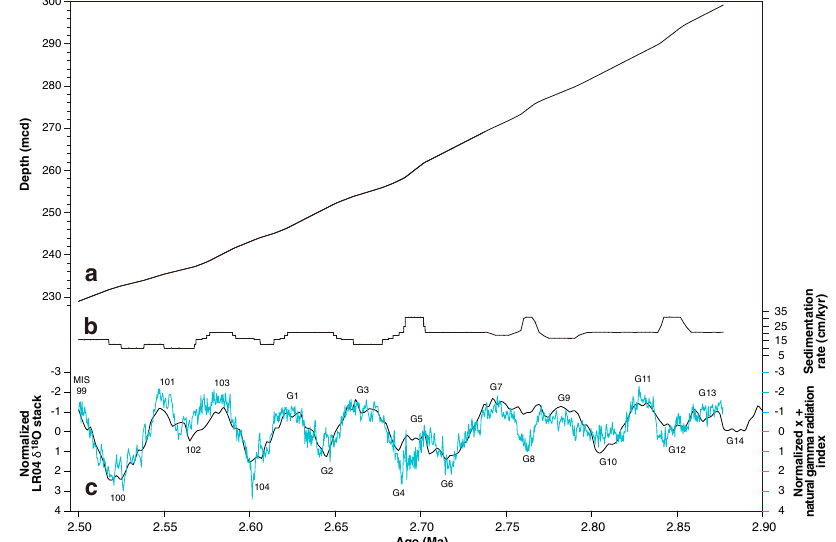
Fig. 4 Late Pliocene – earliest Pleistocene age – depth model and sedimentation rates at IODP Site U1314. a Age – depth plot 27 . b Sedimentation rates. c Age model construction 27 . A normalized χ + natural gamma radiation index record (light blue curve) 21,27 was tuned to the normalized LR04 δ 18 O stack record (black curve) 16